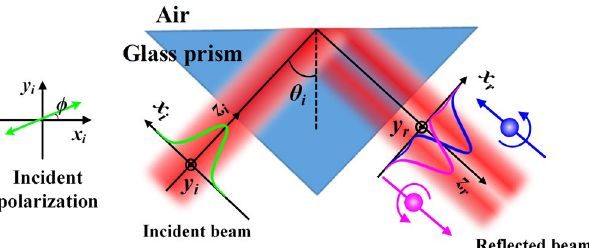
Figure 1. The schematic of the in-plane optical spin splitting. When a linearly polarized Gaussian beam is launched onto the glass-air interface, two opposite spin components of reflected beam shift toward opposite directions, thus split